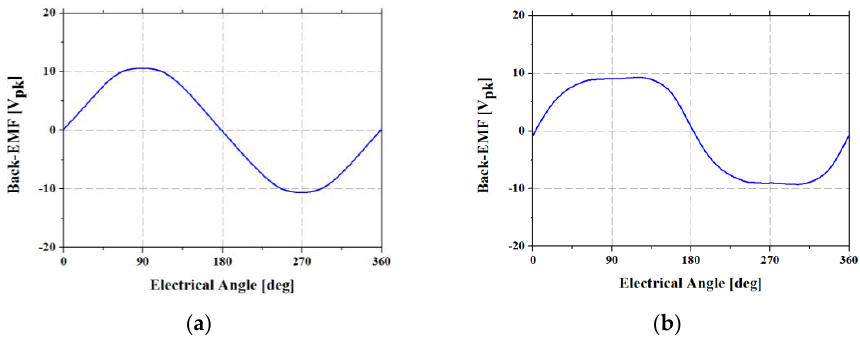
Figure 13. Comparison of back-EMF waveforms: ( a ) base model; ( b ) proposed model.